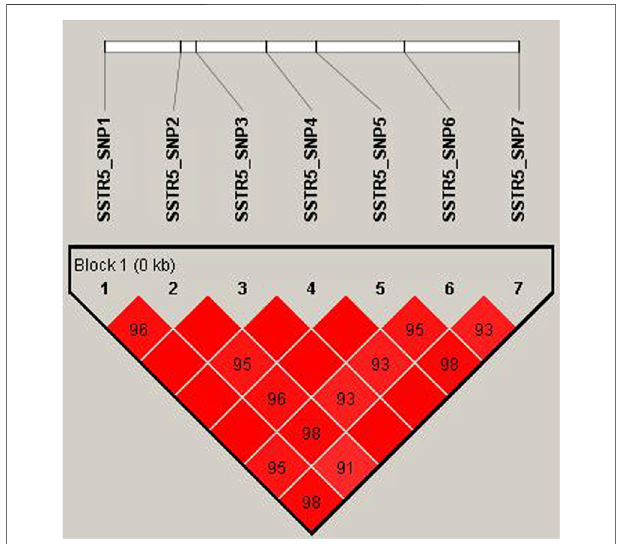
FIGURE 2 | Linkage disequilibrium plot of SNPs in SSTR5 of in Hulun Buir sheep. The linkage disequilibrium (LD) was estimated among